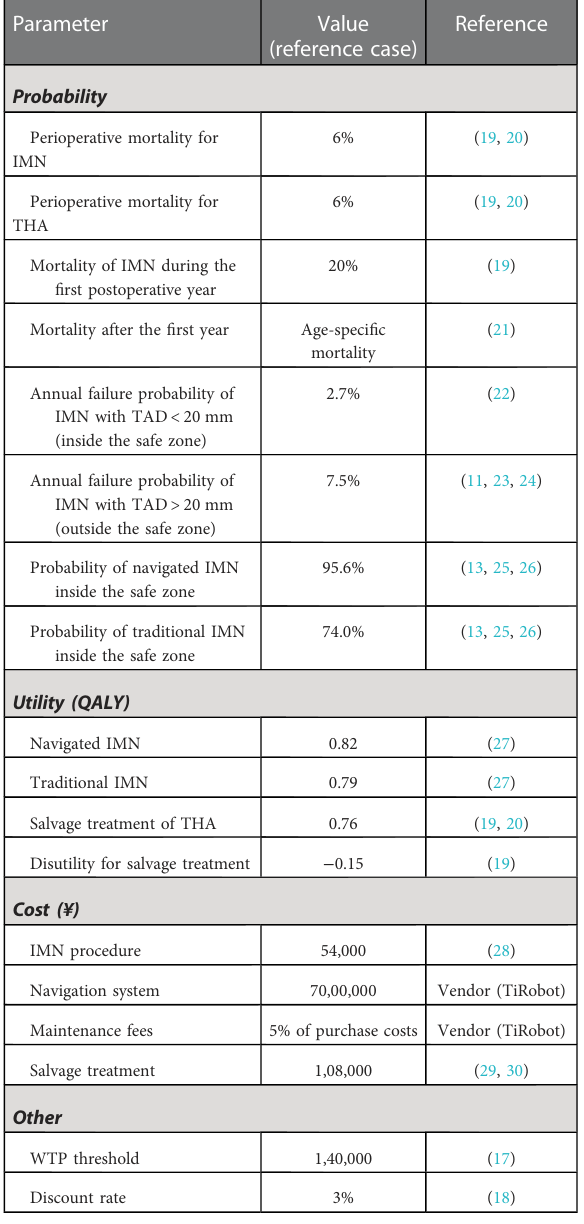
TABLE 1 Values of parameters used in the markov decision model. Parameter Value (reference